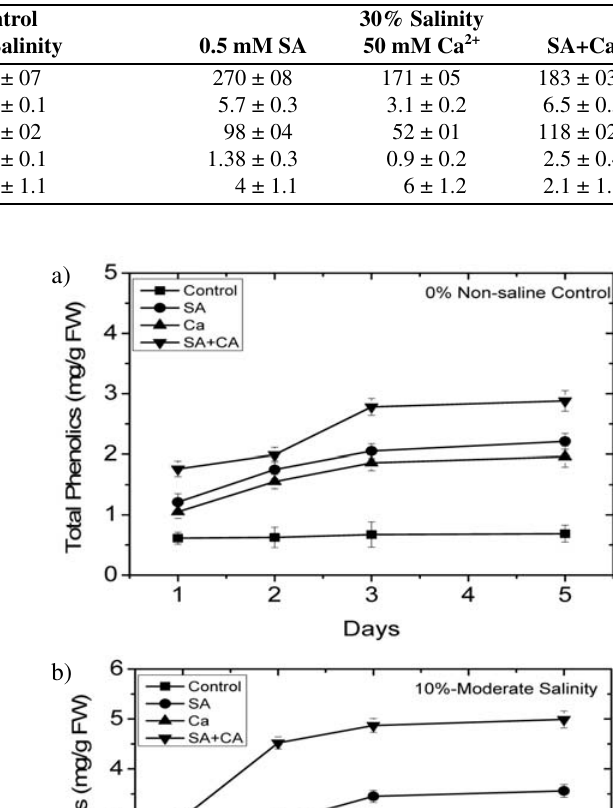
Table 3. Parameters: Chlorophyll, carotenoid and LPO content, PAL and AAO activities; control, 0.5 mM SA, 50 mM Ca 2+ , and combinations of SA+Ca under non-saline and 30% salinity stress.